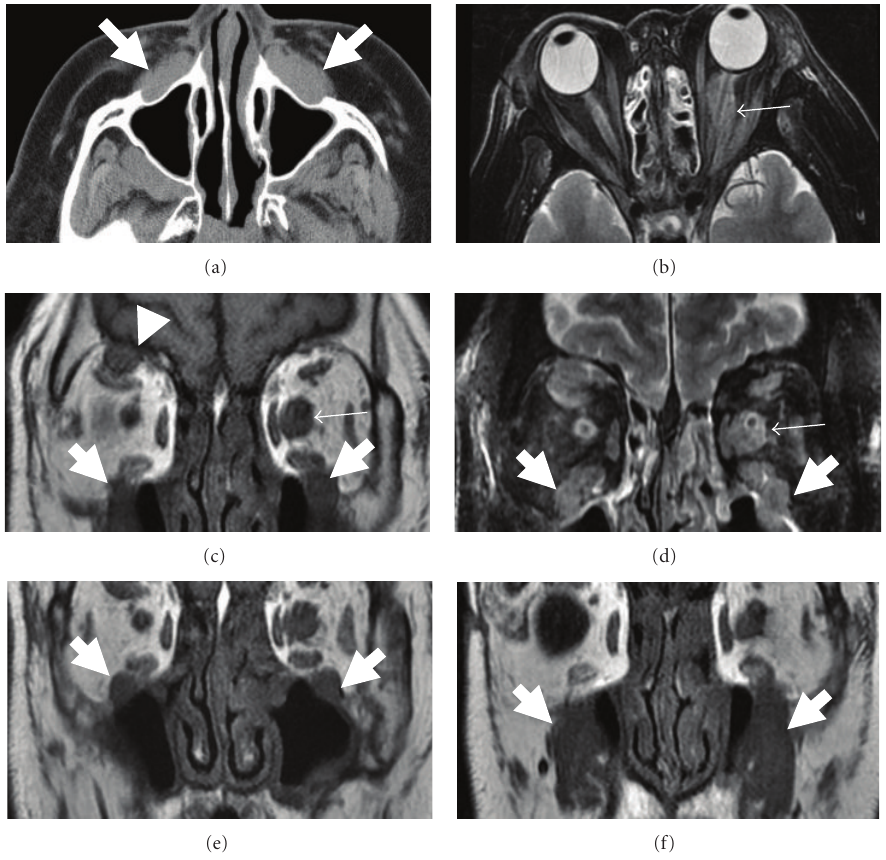
Figure 1: CT (a) and MRI ((b and d): T2-weighted images; (c, e, and f): T1-weighted images) of orbital space in 55-year-old man (case 1). CT image reveals soft tissue around the bilateral infra orbital nerve (a; arrows). MRI shows soft tissue around the left orbital nerve (b–d; small arrows), bilateral infraorbital nerve (c–f; arrows) and right supraorbital nerve (c and d; arrowheads). Left orbital nerve can be detected in the lesion (b and